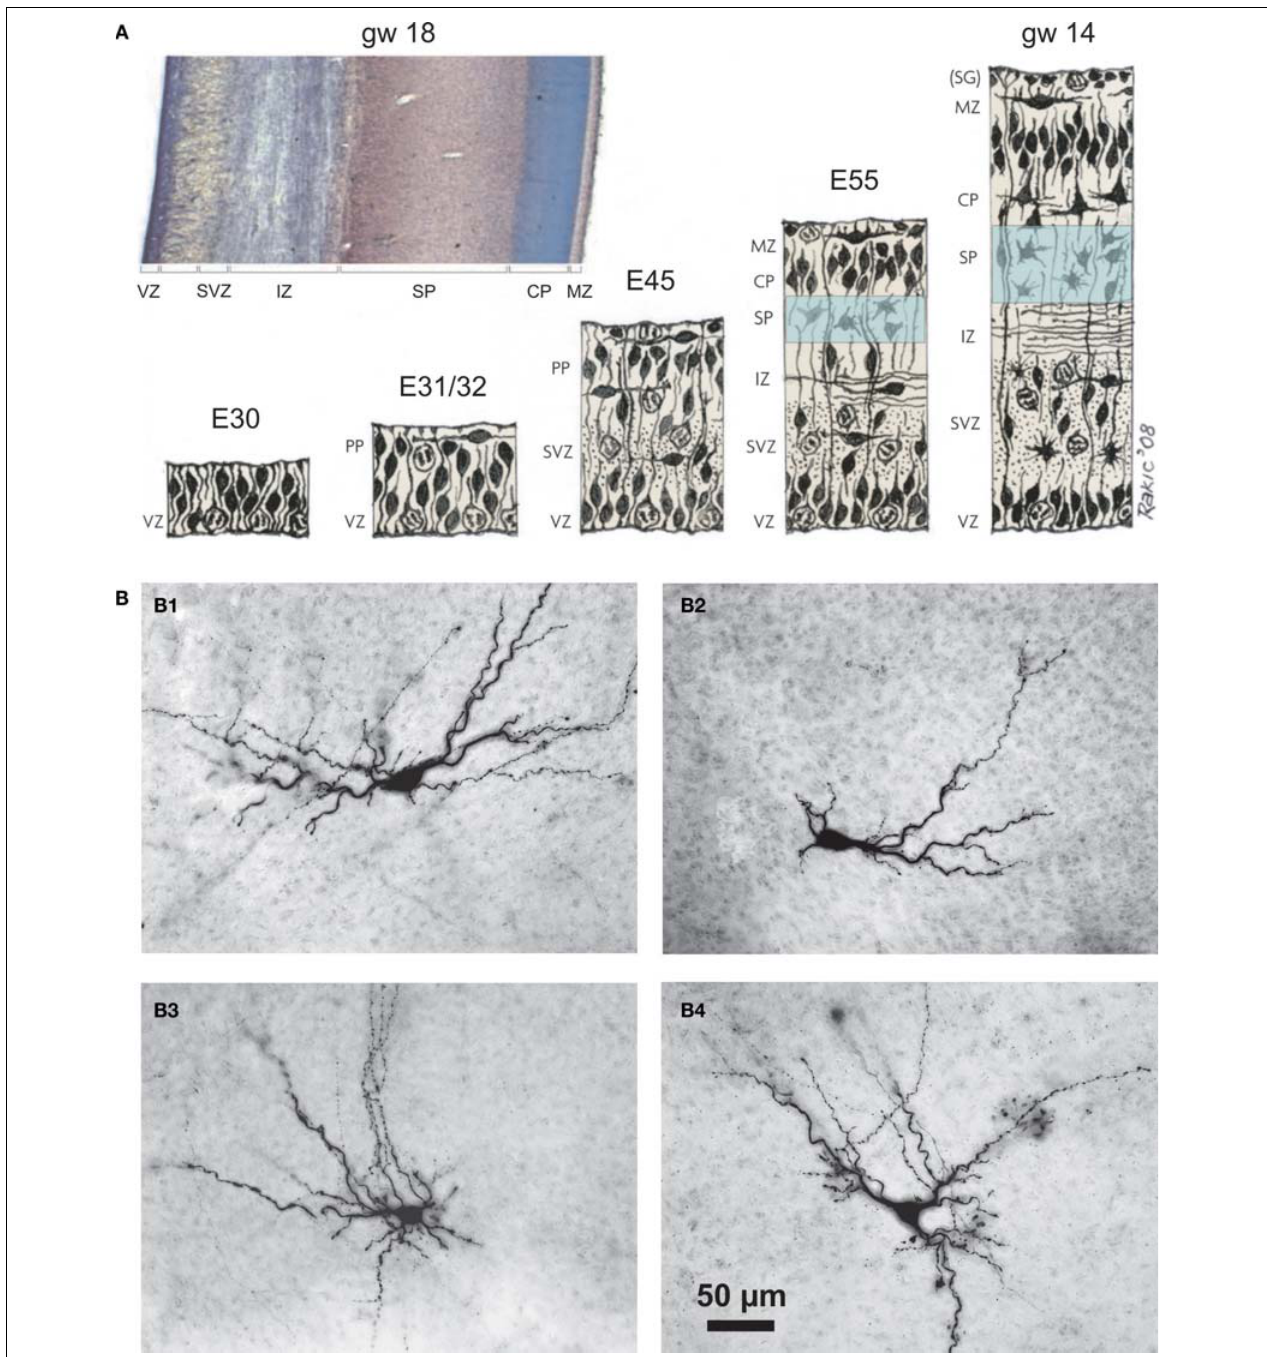
FIGURE 1 | Emergence of the subplate during neocortical development and structural diversity of subplate cells. (A) Prenatal development of the human cerebral cortex as suggested by Bystron et al. (2008). Drawing from Pasko Rakic. Photograph shows coronal brain section stained with cresyl violet of a gestational week 18 human neocortex. Note large expansion of subplate as compared to other neocortical layers. Approximate embryonic day (E) and gestational week (gw) are given for each developmental stage. CP, cortical plate; IZ, intermediate zone; MZ, marginal zone; PP, preplate; SP, subplate; SVZ, subventricular zone; (SG), subpial granular layer (part of MZ); VZ, ventricular zone. (B) Morphological properties of